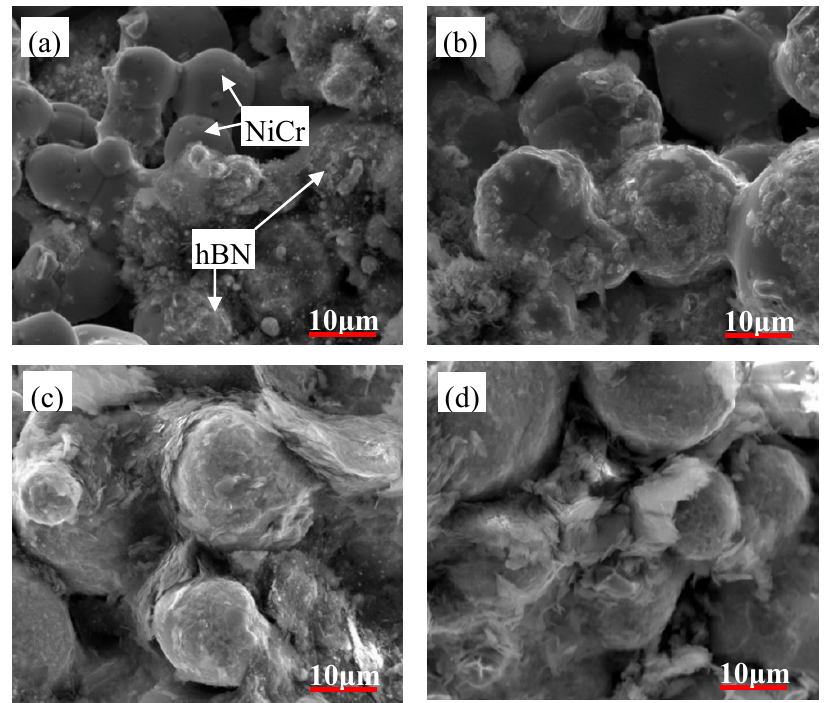
Figure 2. Fracture appearances of NiCr/hBN composites with different hBN contents: ( a ) 8%, ( b ) 9%, ( c ) 10%; and ( d ) 12%.